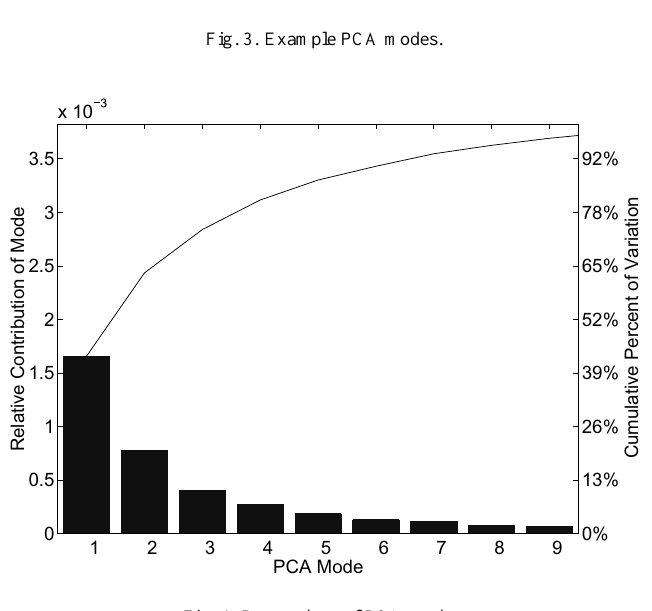
Fig. 4. Pareto chart of PCA